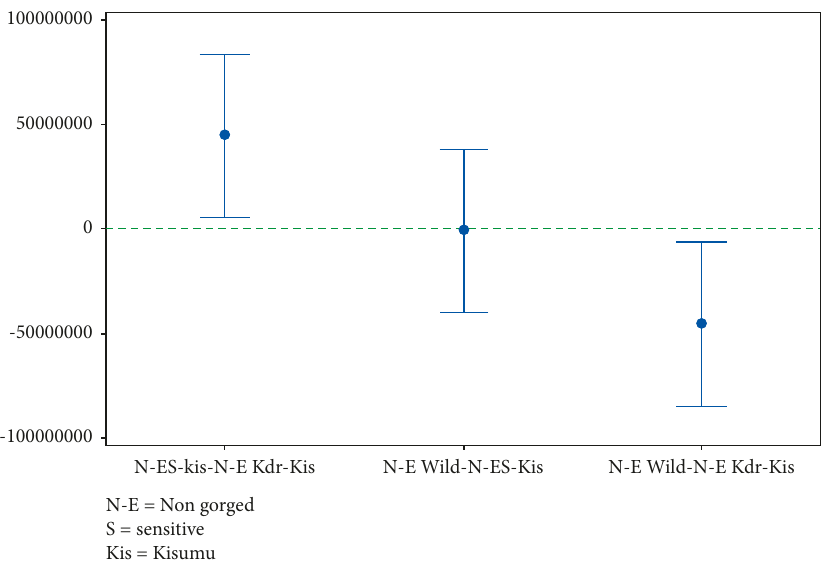
Figure 3: Graph results of Fisher’s test of nongorged